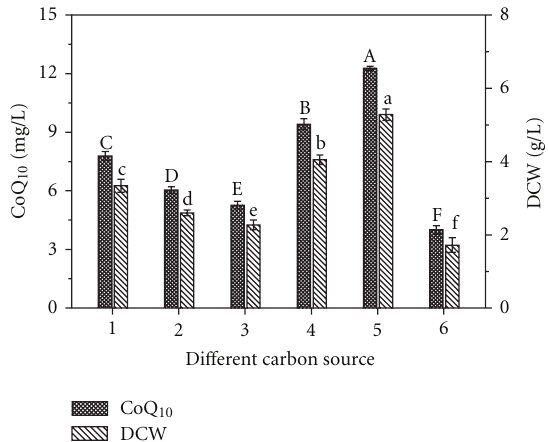
Figure 3: E ff ect of various carbon sources on the cell growth and CoQ10 production. Cells were cultivated in the test tube at 28 ◦ C for 72h. The carbon sources included glucose (1), fructose (2), lactose (3), maltose (4), sucrose (5), and xylose (6). Data are shown as mean ± SD ( n = 3). Means with the same letter are not significantly di ff erent ( P < 0 . 05).